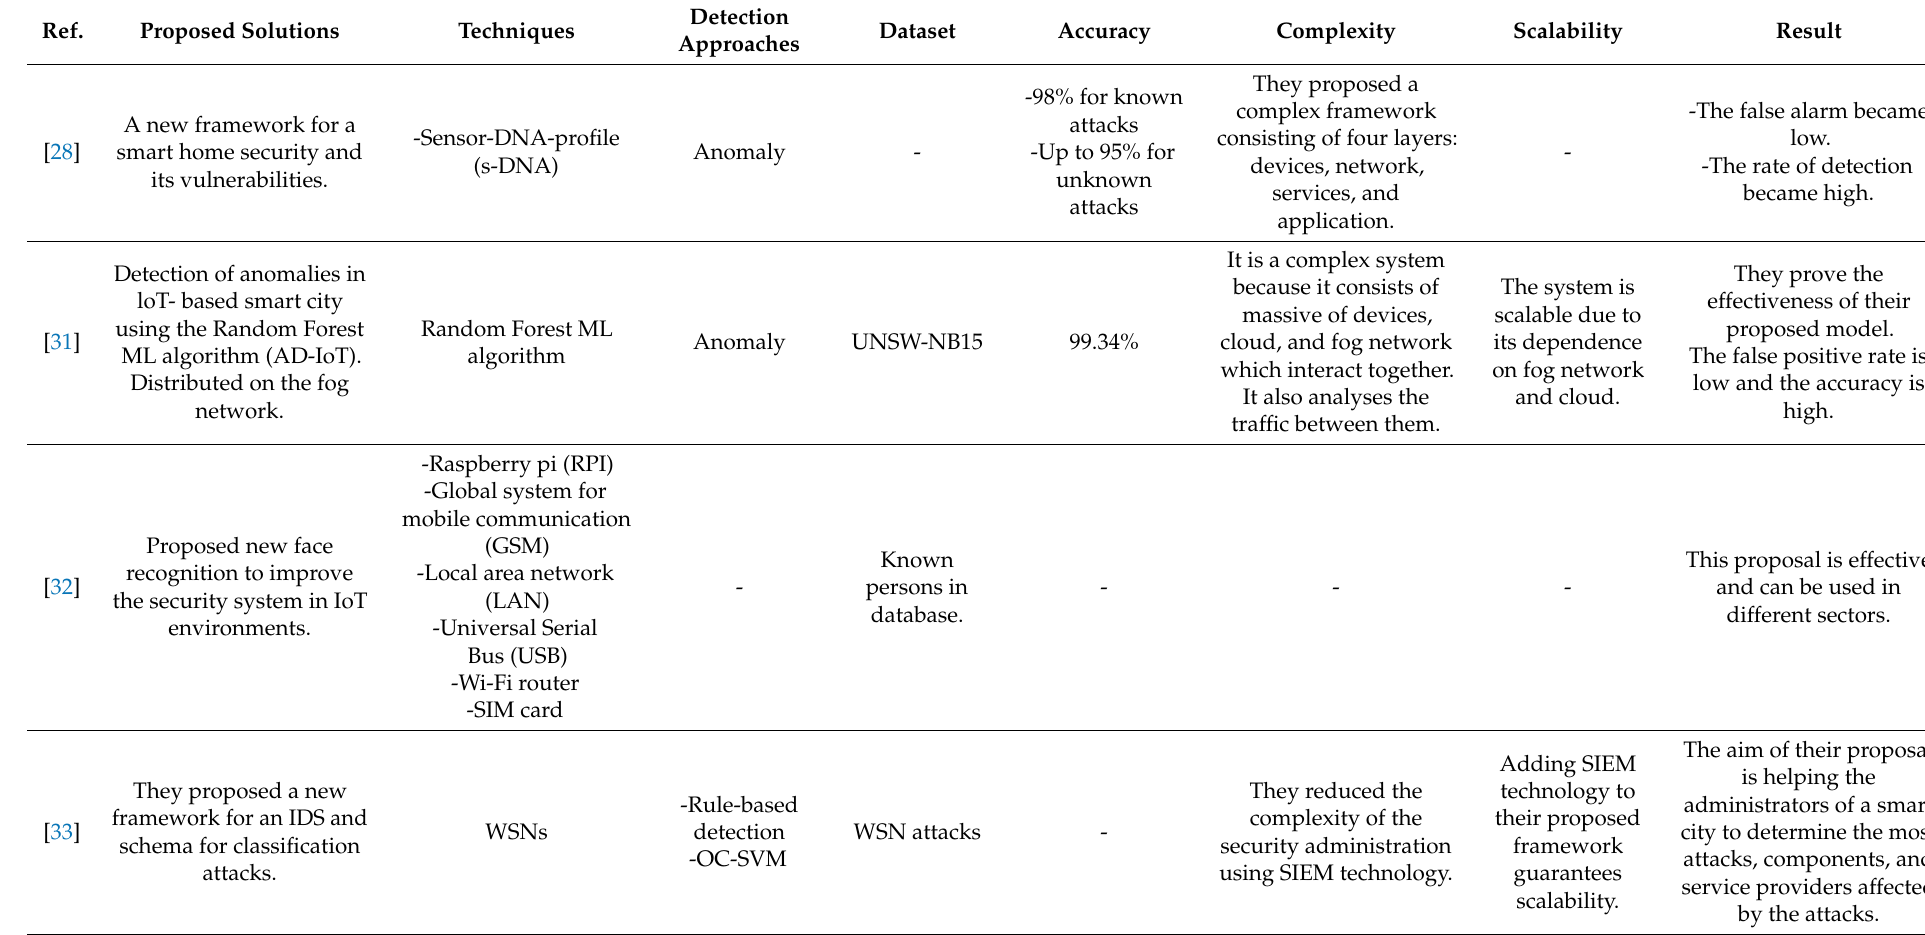
Table 1. Security system in IoT-based smart